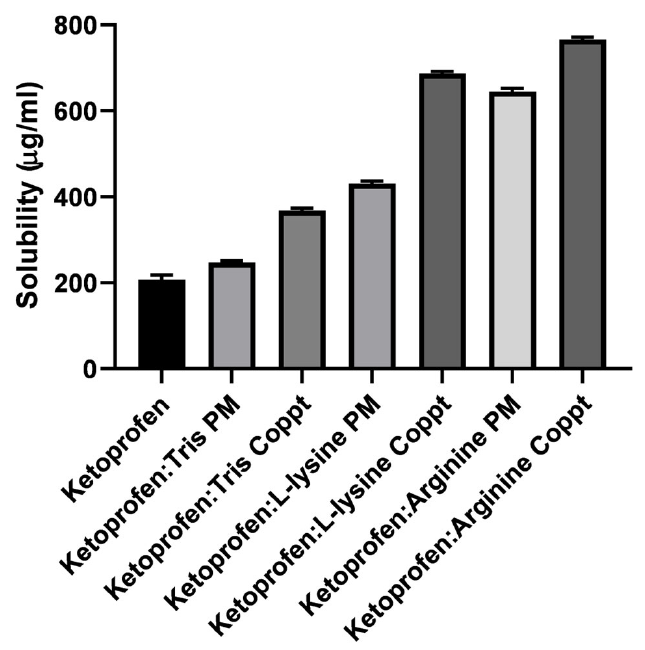
Figure 3. The solubility of ketoprofen in the prepared physical and coprecipitated mixtures.